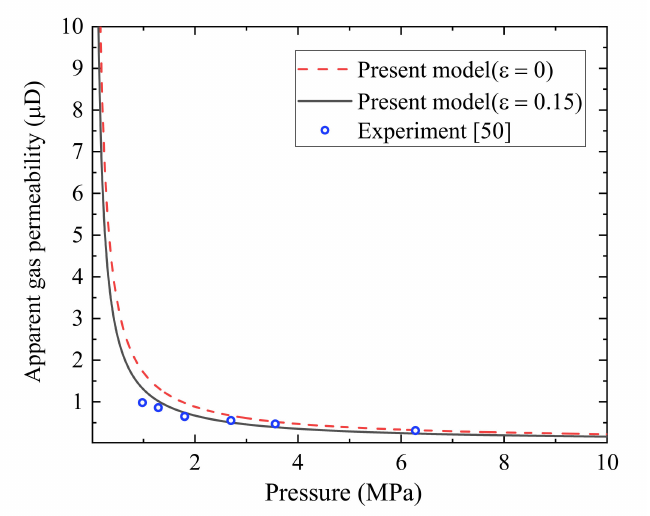
Figure 4. A comparison on gas apparent permeability of tight reservoir rocks between our fractal analytical model and existing experimental data